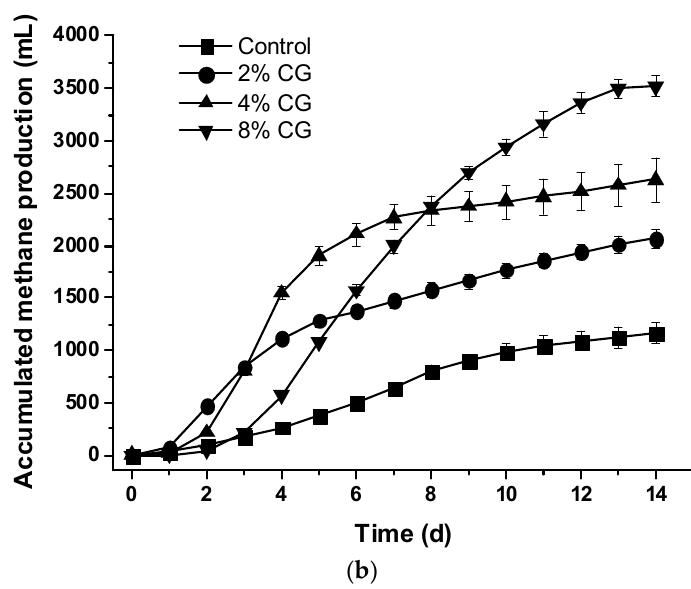
Figure 4. Effects of adding different percentage of crude glycerol on ( a ) daily methane production and ( b ) accumulated methane production.